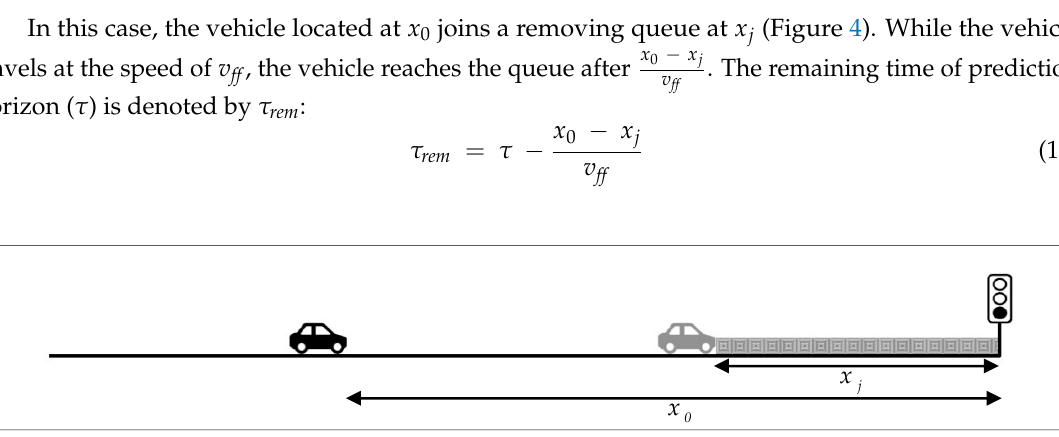
Figure 4. Illustration of Case 1. This case describes a vehicle that is located at x 0 at time t 0 and then joins the queue at x j .